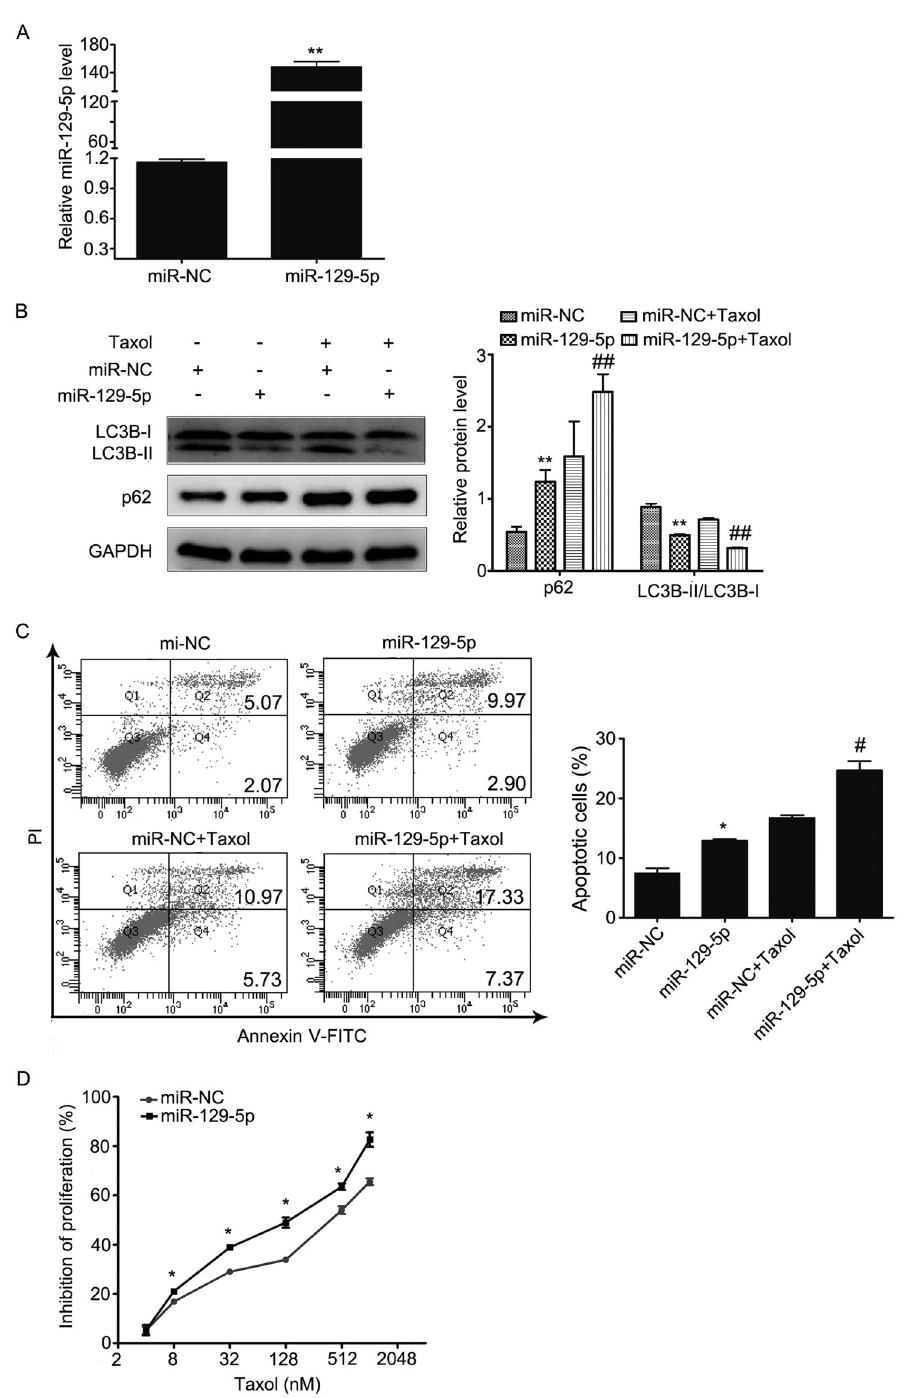
Figure 3. A , Relative miR-129-5p expression was detected by qRT-PCR analysis in MCF-7 cells transfected with miR-129-5p mimics or miR-NC. MiR-NC acted as a negative control. B and C , Cells were transfected with miR-NC or miR-129-5p mimics and then treated with 31.2 nM Taxol for 24 h. B , LC3B-I, LC3B-II, and p62 expression in MCF-7 cells were determined by western blot. C , Cellular apoptosis was determined by fl ow cytometry. D , Cell proliferation was determined by the CCK-8 assay after transfection with miR-NC or miR-129-5p mimics and treatment with different concentrations of Taxol for 24 h. Data are reported as the means ± SD of three independent experiments. *P o 0.05, **P o 0.01, vs miR-NC group; # P o 0.05, ## P o 0.01, vs miR-NC + Taxol group